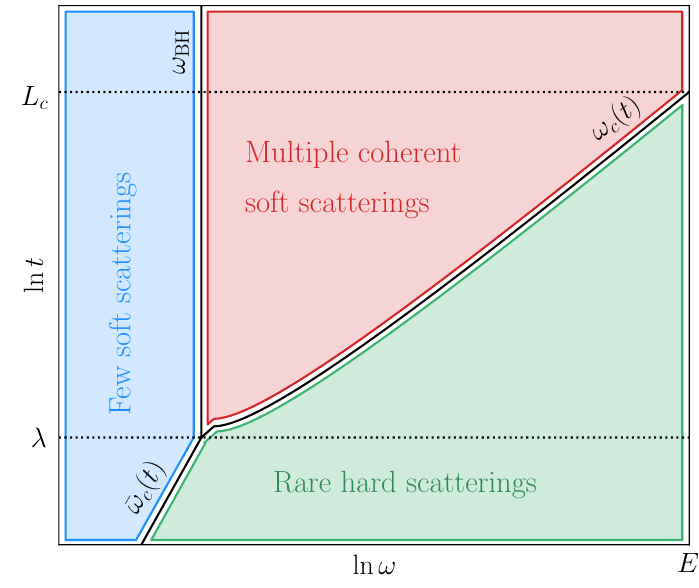
Figure 3 . The phase space for medium-induced emissions designated to the leading scattering processes. The main length scales of the problem are λ and the critical length L c , corresponding to the characteristic energies ω and E , see text for further BH